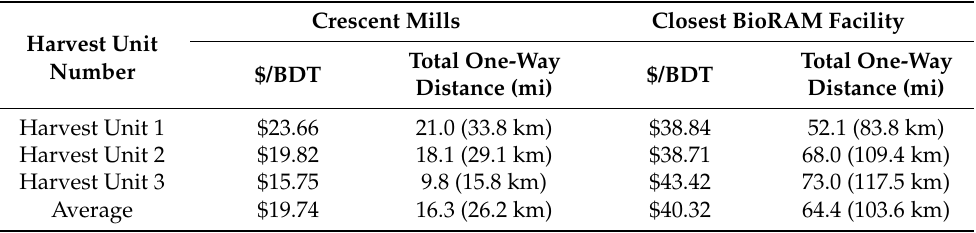
Table 8. Comparison of haul costs between Crescent Mills and the closest BioRAM